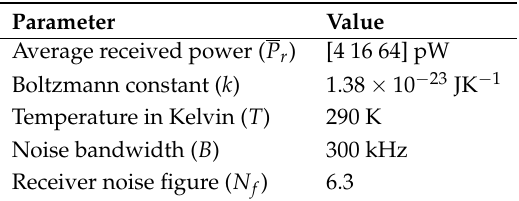
Table 4. Parameters used in performance analysis